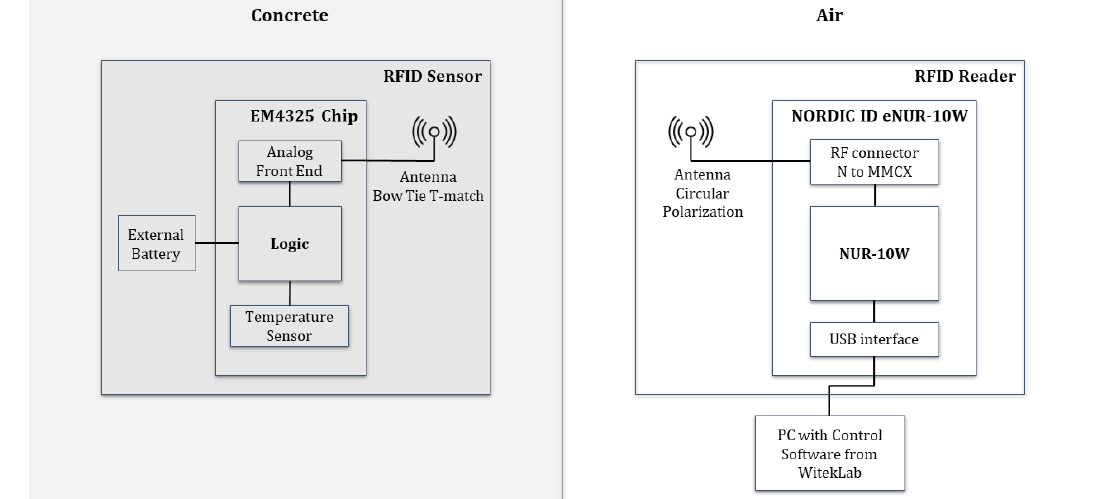
Figure 1. Block Diagram of the RFID-based system for wireless temperature